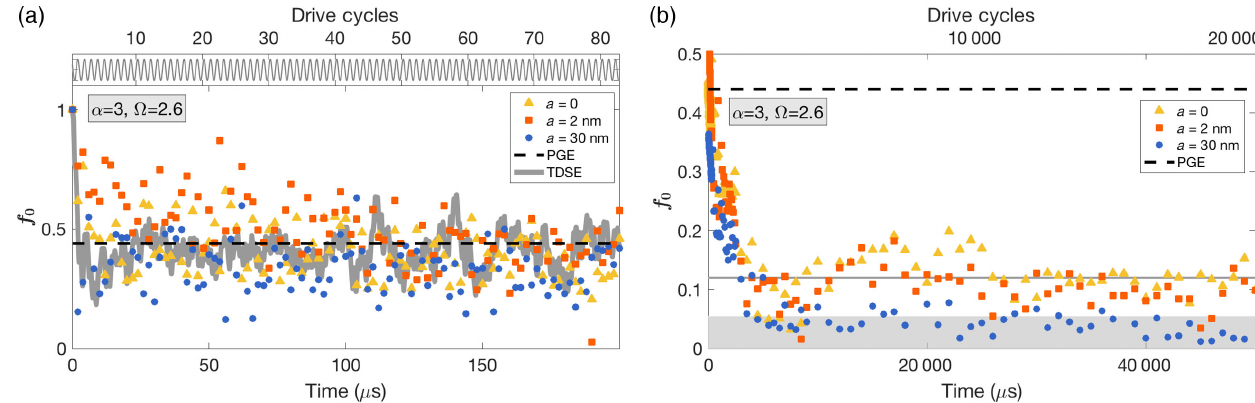
FIG. 4. Effect of interaction on the long-time evolution of Floquet matter. (a) Short-time evolution of f 0 for a drive with Ω ¼ 2 . 6 and α ¼ 3 , at three different values of the s -wave scattering length a . Regardless of interaction strength, f 0 fluctuates near the PGE value (dashed line). Solid gray line shows the solution to the time-dependent Schrödinger equation for the noninteracting case. Top panel shows the driving waveform. (b) f 0 as a function of time for much longer times, for the same drive and interaction parameters. Data are boxcar averaged into 200 - μ s bins. The noninteracting and weakly interacting samples attain a second plateau (solid line) well below the PGE value (dashed line), while the strongest-interacting sample decays to a high-temperature state consistent with ergodicity. Shaded area indicates the estimated noise floor: At long times, we measure no significant ground-band occupation only for the strongest- interacting sample.